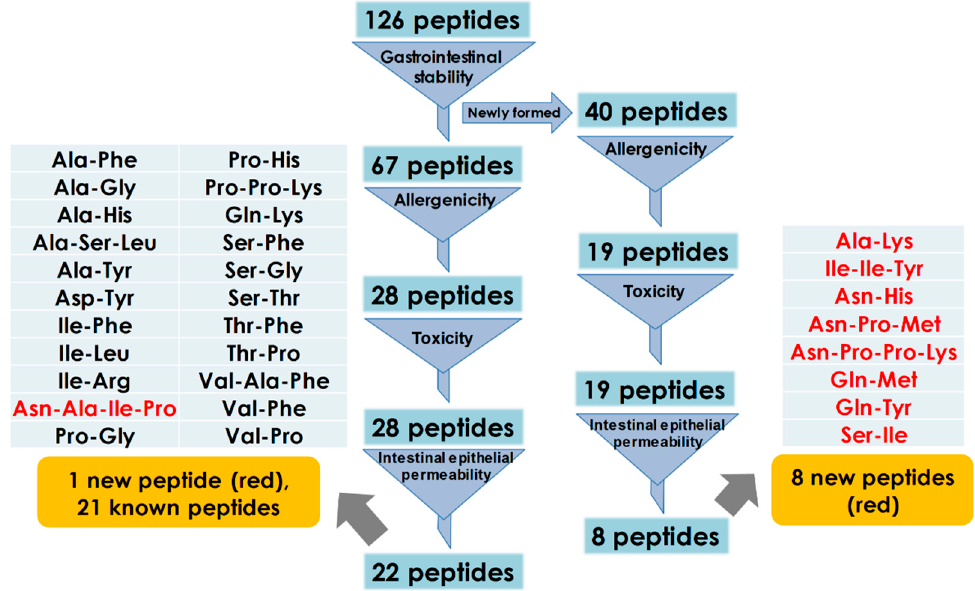
Figure 3. Screening process for ACE inhibitory peptides based on toxicity, allergenicity, gastrointestinal stability, and intestinal epithelial permeability.